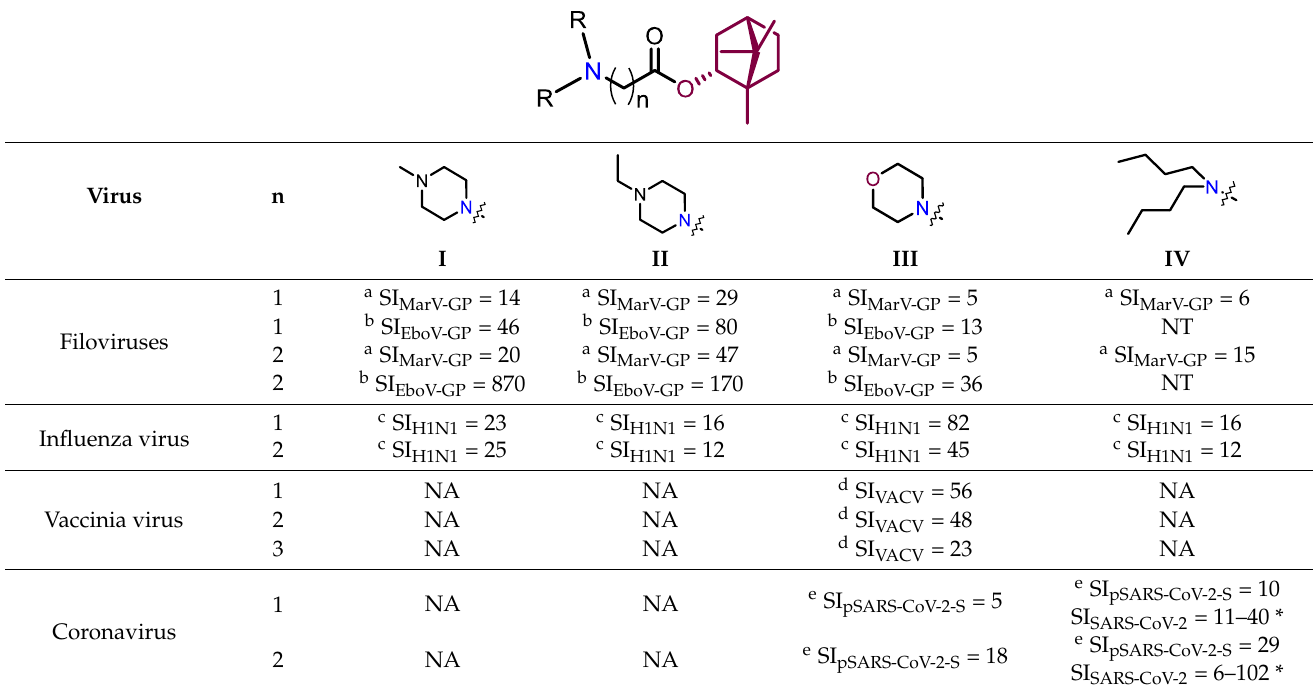
Table 1. Structure and antiviral activity of (-)-borneol-based esters.